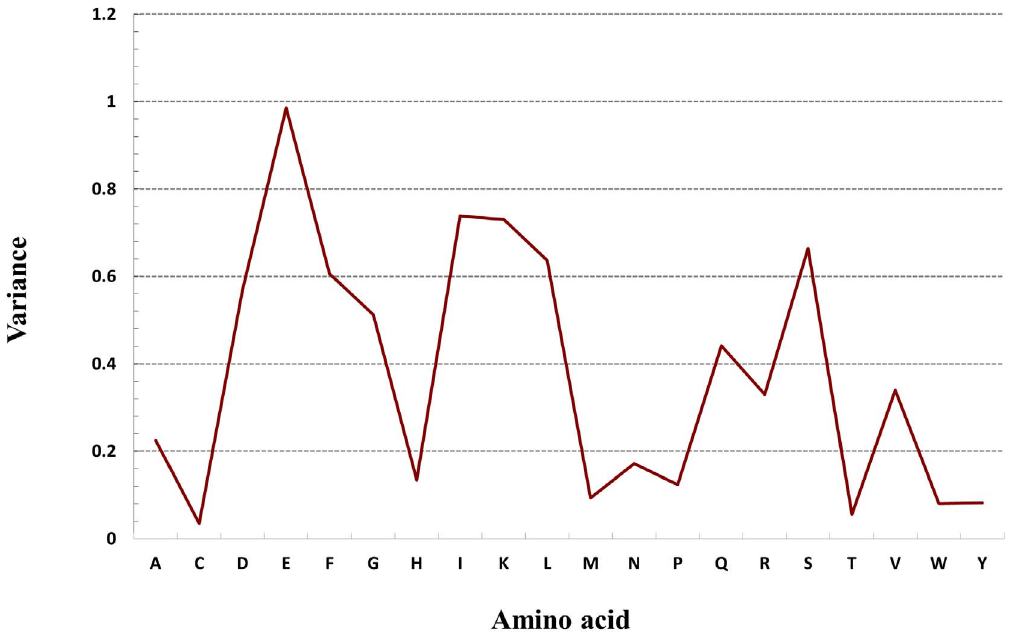
Figure 2. Variance in a mino acid composition of transporter proteins. The variance in amino acid residues across amino acid transporters, anion transporters, cation transporters, electron transporters, protein/mRNA transporters, sugar transporters, other transporters, and non- transporters is plotted.